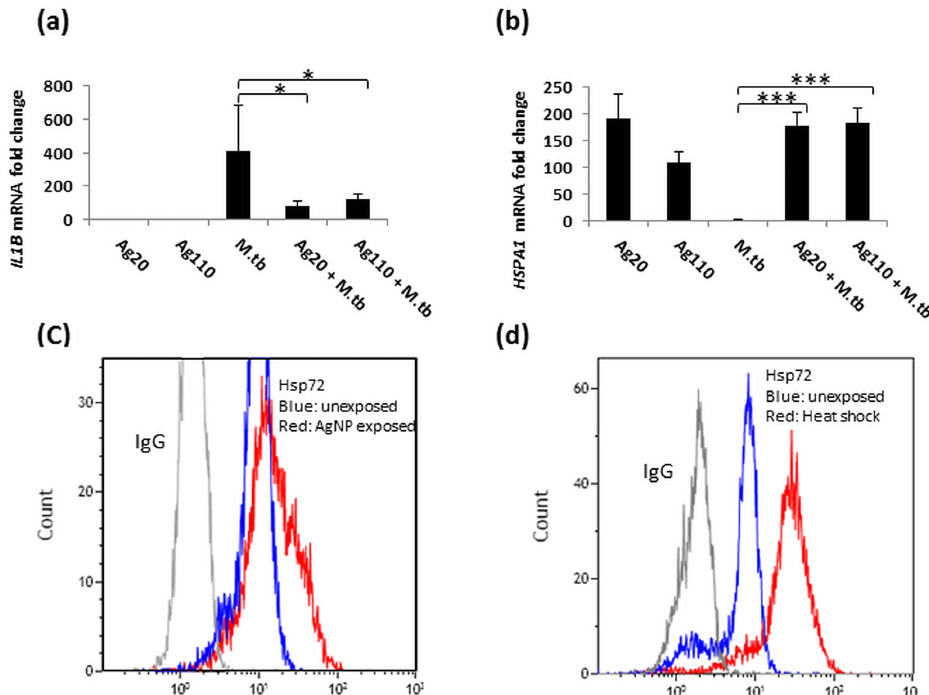
Fig 11. Validation of Hsp72 expression induced by AgNP in MDM. RNA from the samples used for TLR arrays (Fig 7) was used to validate array results by qRT-PCR using primers corresponding to IL1B (a) and HSPA1 (b) (see Materials and Methods). Each data point (Y-axis) represents mean fold-changes ± SD from MDM of 5 independent subjects. Statistically significant changes relative to unexposed MDM are marked by * ( p < 0.05) or *** ( p < 0.001). Unexposed (blue line) and Ag20-citrate exposed (10 μ g/mL for 4 hours at 37°C at 5% CO 2 in a humidified environment, red line) MDM were stained with anti-Hsp72 Ab or control IgG (grey line) ( c ). Data shown in ( c ) are representative of the FACS profile from one experiment, which was repeated twice using MDM from a total of three different donors. MDM exposed to 42°C heat shock for 1h followed by incubation at 37°C for 3h stained with anti-Hsp72 Ab served as a positive control (d). Blue and red lines represent the unexposed and heat shocked anti-Hsp72-stained MDM. Unexposed MDM stained with Isotype-matched IgG Ab are shown by gray lines in ( c ) and ( d) , representative of two independent